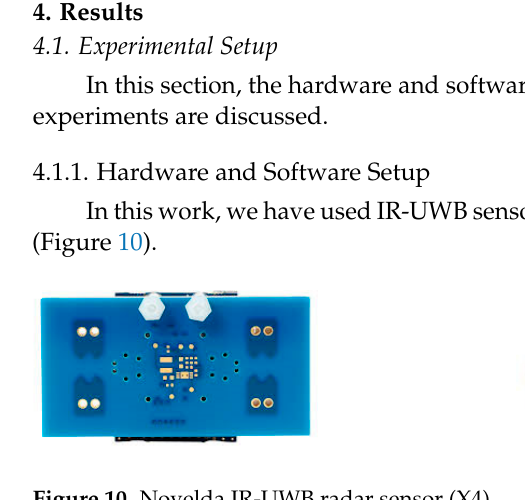
Figure 10. Novelda IR-UWB radar sensor (X4) .